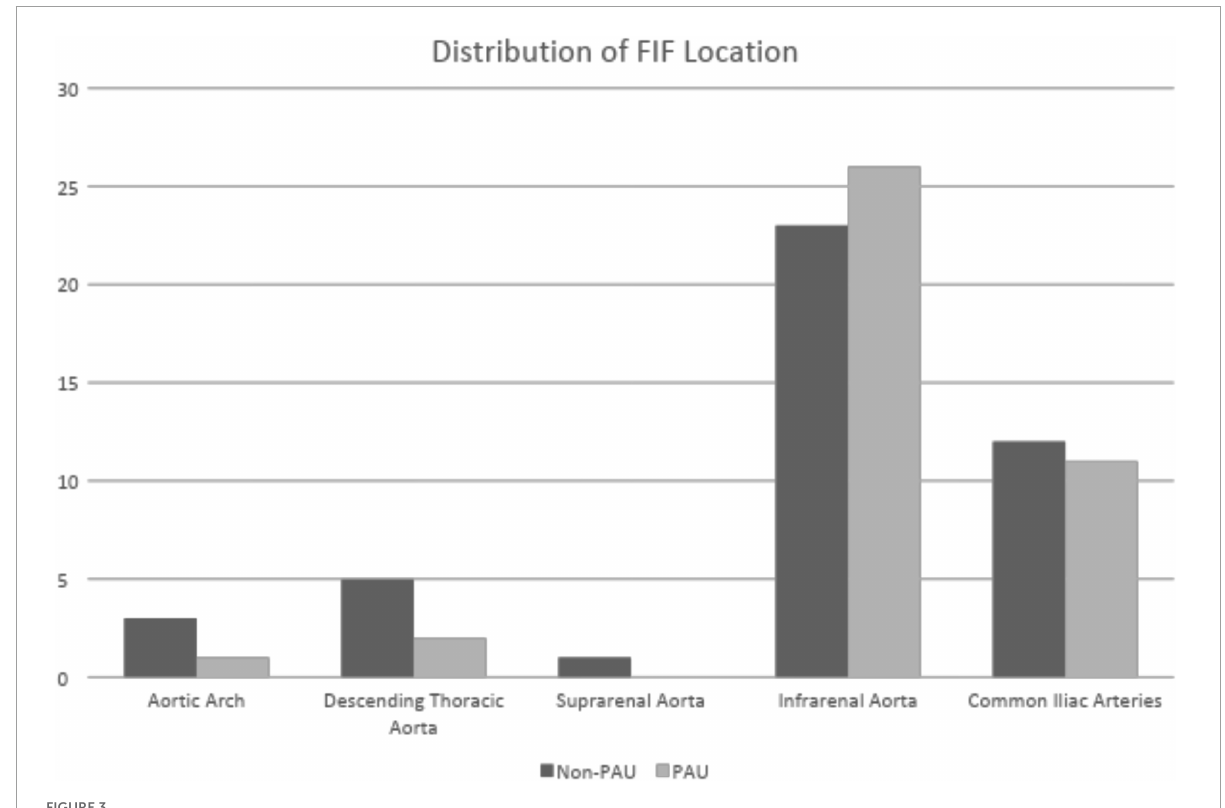
FIGURE3 Histogram of FIF anatomic location by aortic segment.